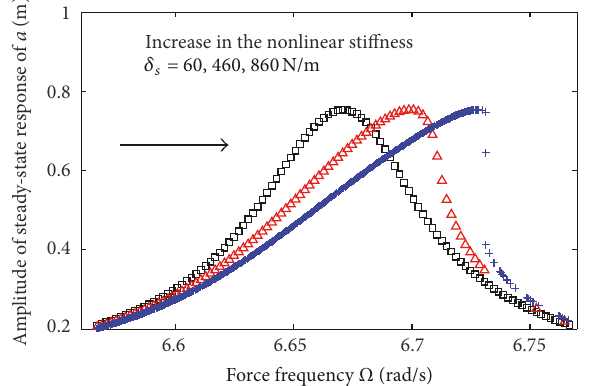
Figure 4: The effect of varying nonlinear stiffness 𝛿 𝑠 on frequency response of vibration 𝑎 . 𝛿 𝑠 = 60 N / m ( black squares), 𝛿 𝑠 = 460 N / m (red triangles), and 𝛿 𝑠 = 860 N / m (blue